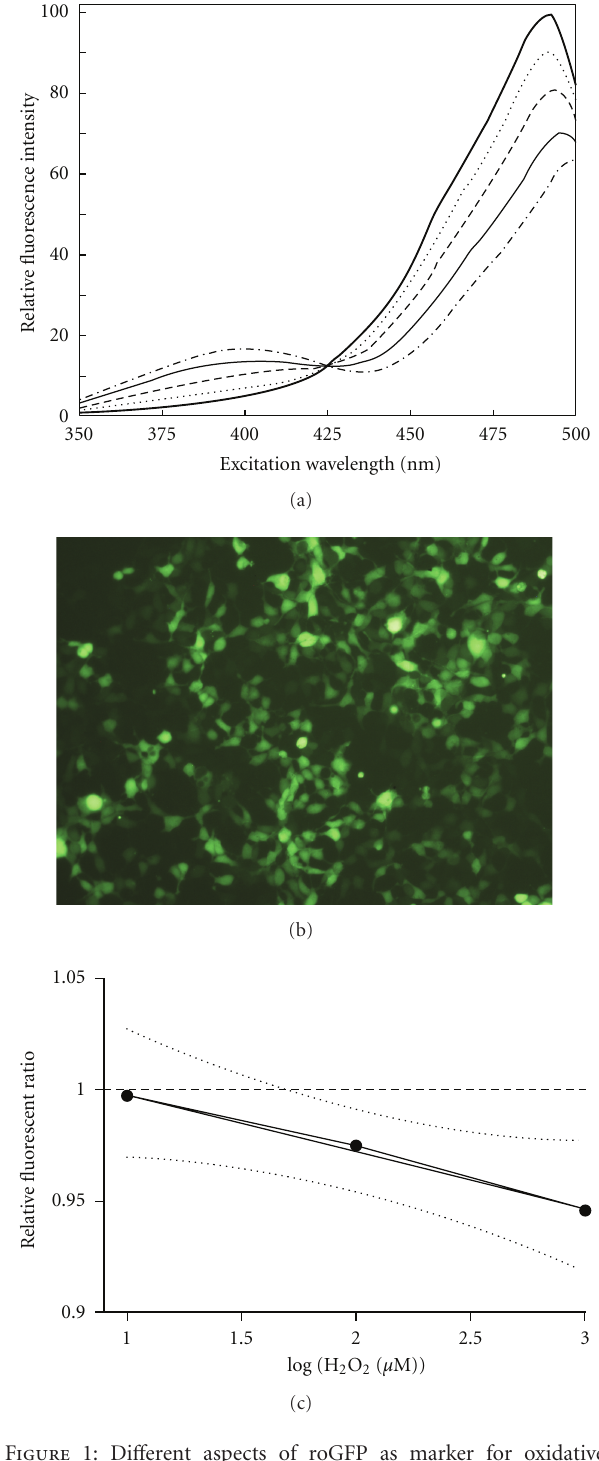
Figure 1: Di ff erent aspects of roGFP as marker for oxidative changes in cells. (a) Emission intensity of roGFP measured at serial excitation points. The flat line represents reductive conditions while the semidotted line represents oxidative conditions. The lines in between are di ff erent levels of red-ox conditions (image modified from Hanson et al. [25]) (b) Image of HEK293 cells stably trans- fected with roGFP. (c) Linear regression of log-transformed con- centration of H 2 O 2 in roGFP cells. Slope is − 0.02617 ± 0.004004, Y intercept when X = 0 is 1.027 ± 0.008649, and R 2 is